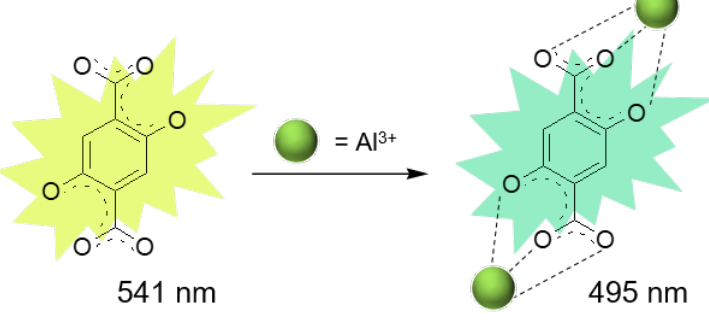
Scheme 2. Plausible mechanism for the binding of Al ions to DHT-K.